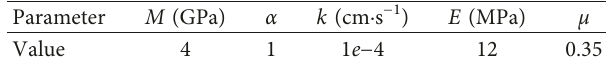
Table 2: The mechanical parameters of one-dimensional consol- idation test.